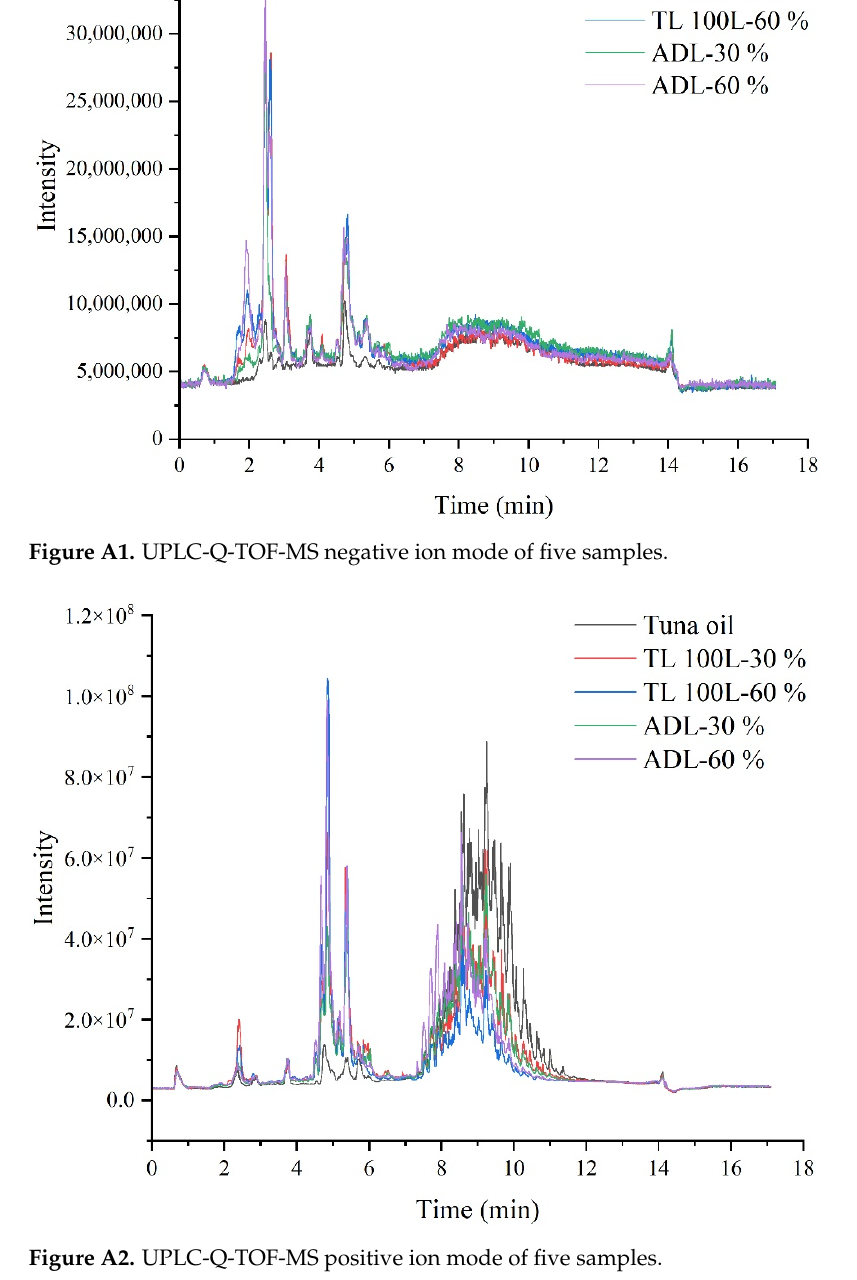
Table A1. Composition and content of acylglycerols in five samples.